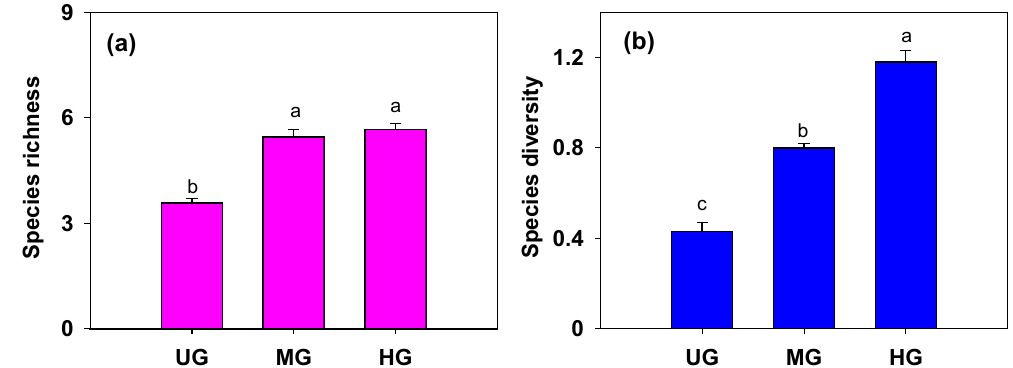
Figure 5. Species richness (a) and alpha diversity (b) at 0.25m 2 scale for sites exposed to three grazing intensities (UG–ungrazed, MG– moderate grazing, HG–heavy grazing). Bars represent + standard error. Different letters mean significant difference at P<